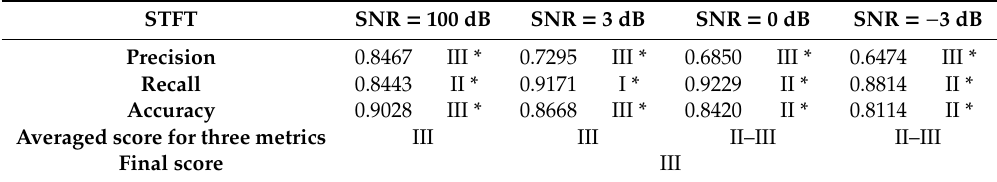
Table 15. Classification results: STFT.